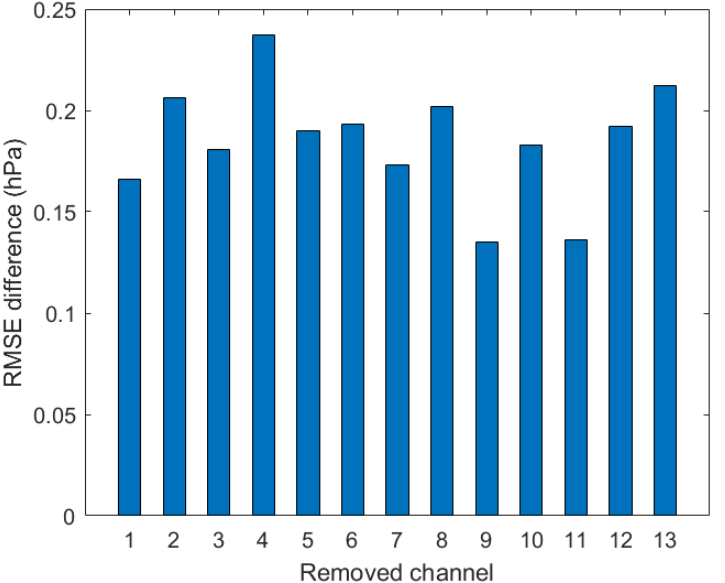
Figure 10. The difference between the practical retrieval accuracy from the partial channel combi- nation and the practical retrieval baseline accuracy. Table 4. The SSP retrieval results using the observed brightness temperatures of the partial channel combinations.